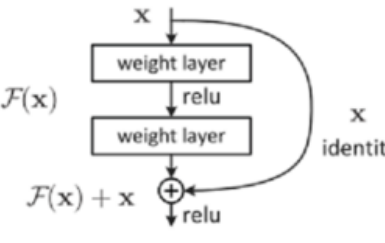
Figure 4. Residual principle.